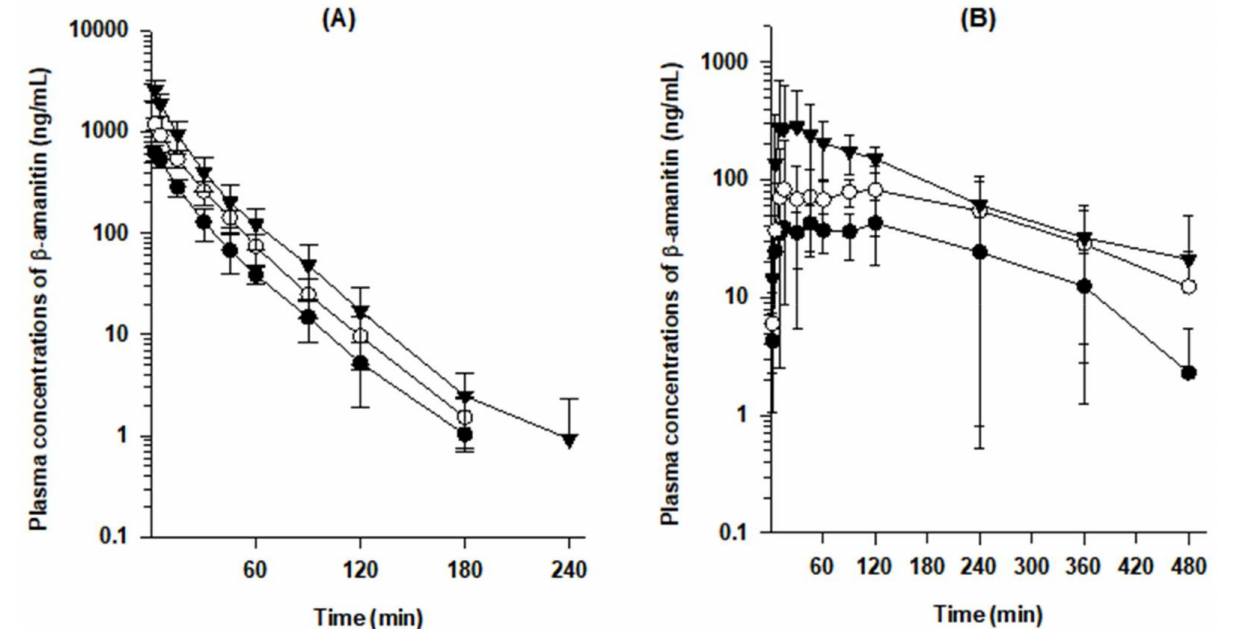
Figure 2. ( A ) Mean plasma concentration–time curves of β -amanitin in male ICR mice after an intravenous injection.